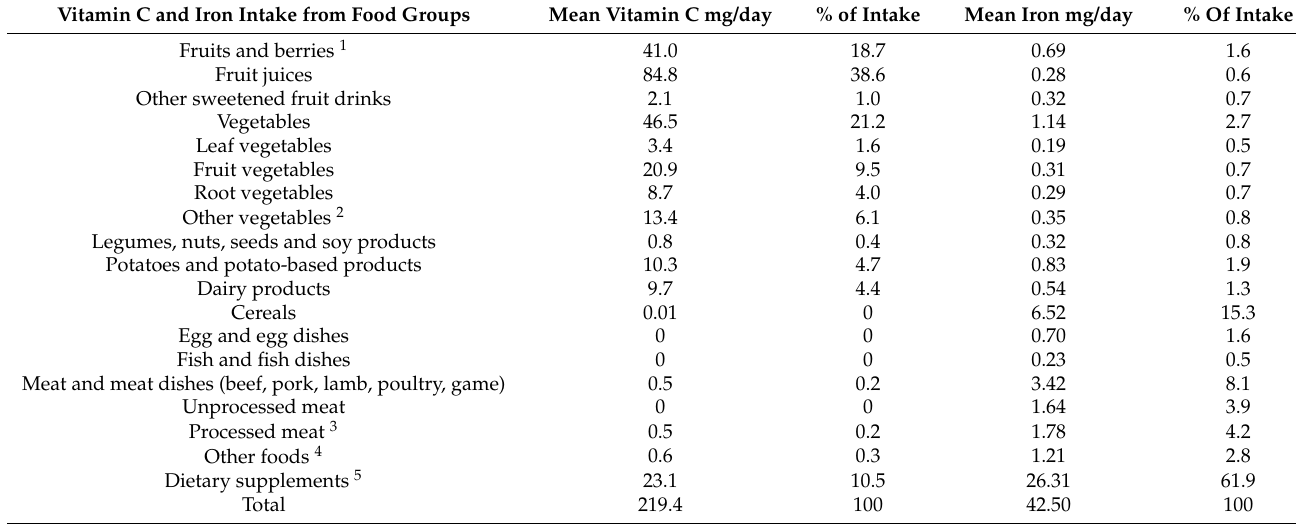
Table 2. Maternal intake of vitamin C and iron during pregnancy from food groups, DIPP Nutrition Study, Finland. Vitamin C and Iron Intake from Food Groups Mean Vitamin C mg/day % of Intake Mean Iron